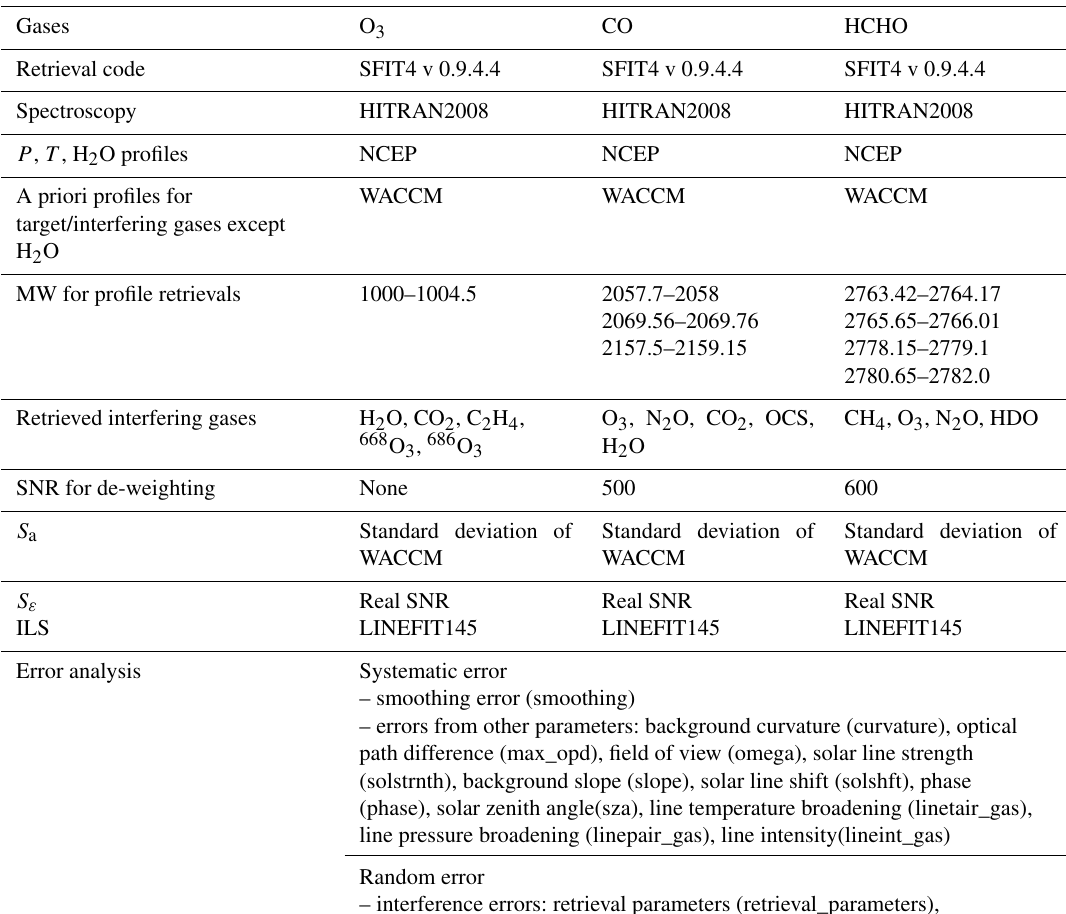
Table 1. Summary of the retrieval parameters used for O 3 , CO, and HCHO. All micro-windows (MWs) are given cm − 1 .